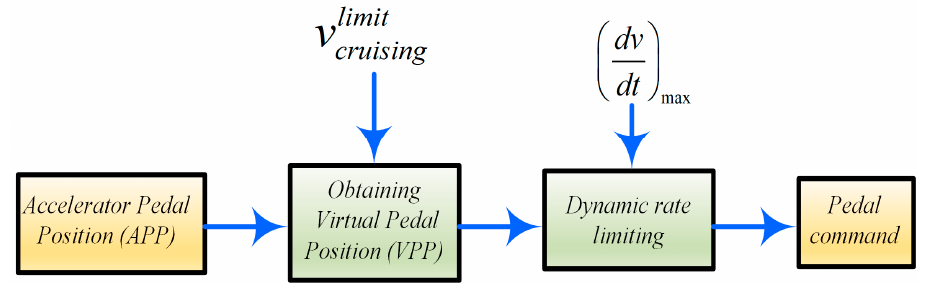
Figure 6. The proposed APSA scheme.